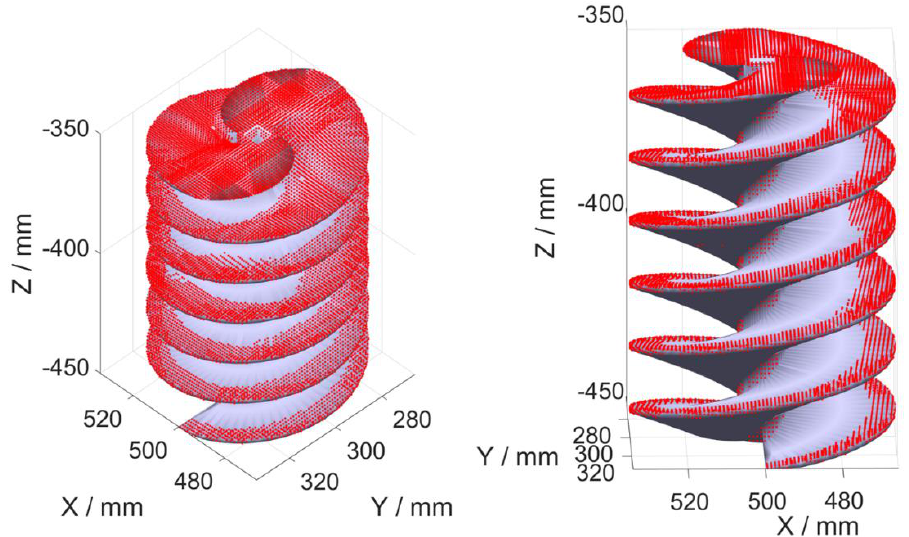
Figure 15. A virtual measurement of an Archimedean screw with the measured points in red. Figure 16. A virtual measurement of an Archimedean screw with the measured points in